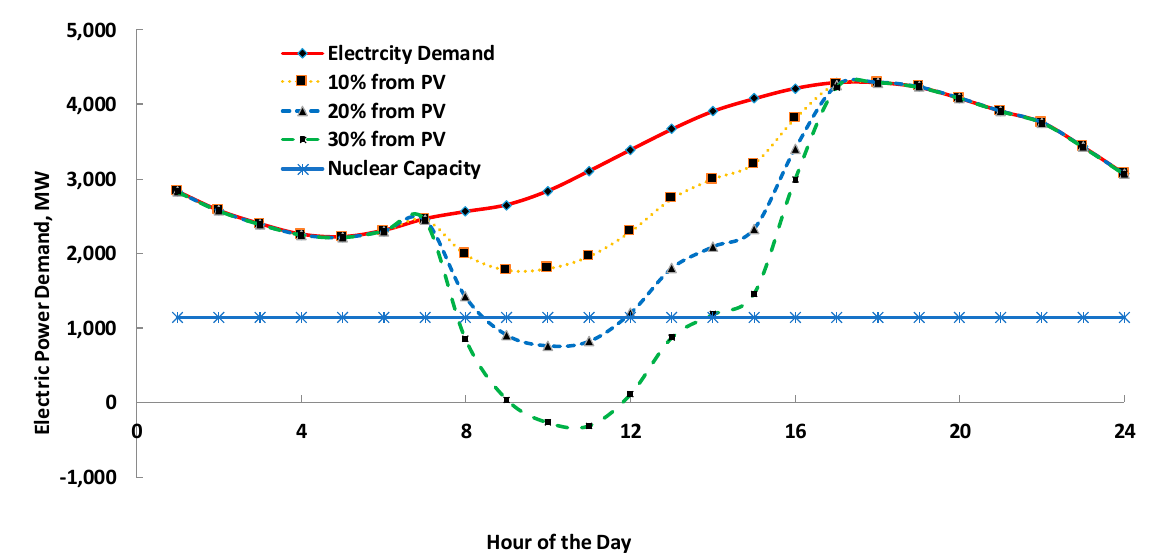
Figure 1. The development of the duck curve in the supply of electric power, when solar energy supplies an increasing fraction of the total annual energy consumed.